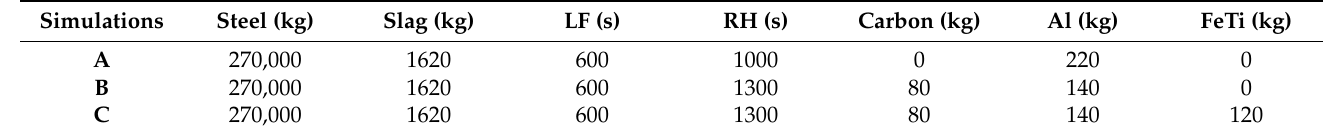
Table 2. The mass of steel, slag, and the additions in the different simulations.